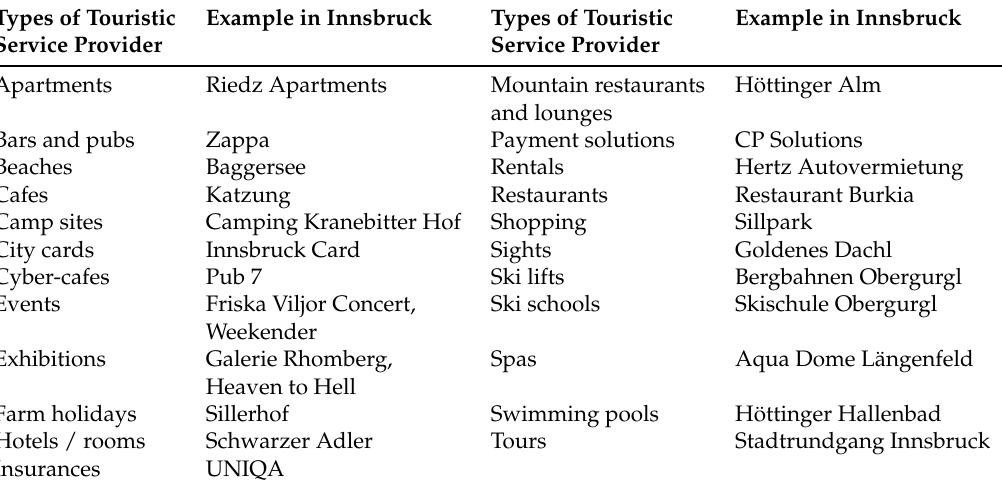
Table 1. Types and examples of touristic service providers (from